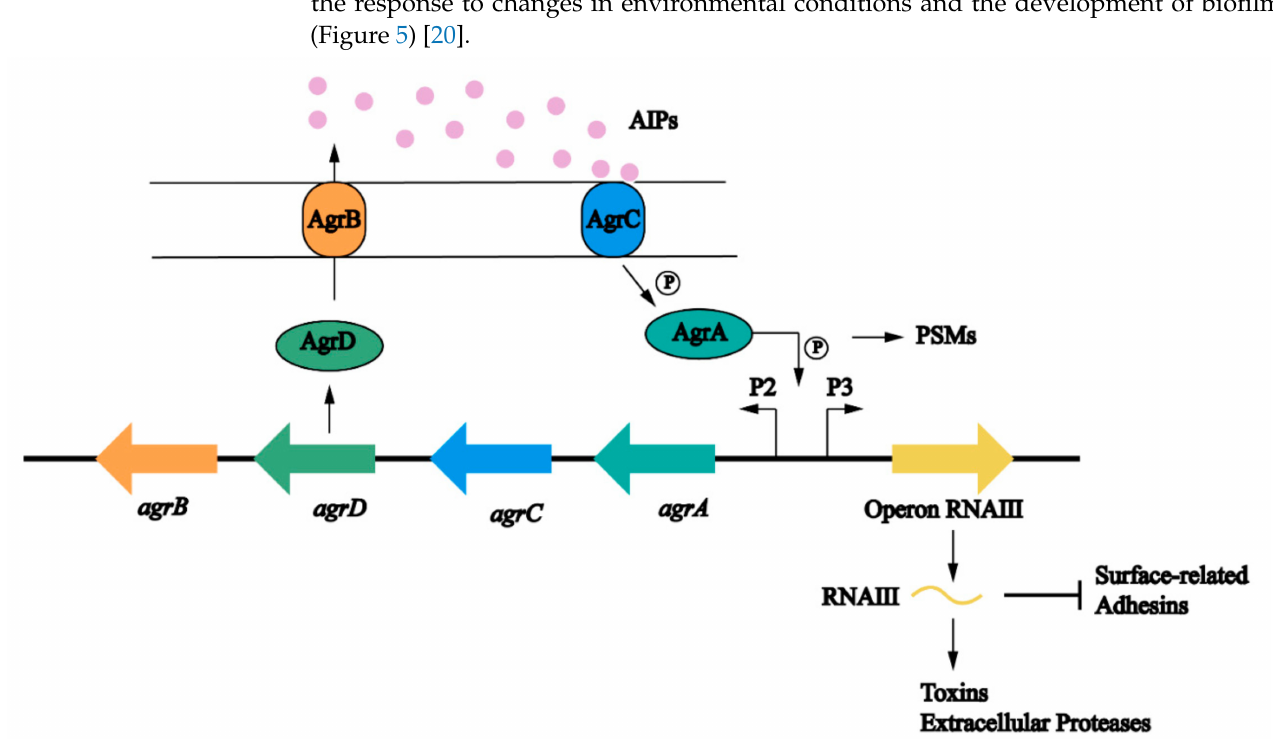
Figure 4. The role of the Agr quorum sensing system in biofilm formation in S. aureus . The Agr system is controlled by agr operon. AgrD is the precursor of self-induced peptides (AIPS), which is modified by AgrB and secreted into the extracellular matrix. AIPs are intracellular signal molecules that respond to cell density. When the bacterial density increases, AIP activates the transmembrane protein AgrC. Phosphorylated AgrC further activates AgrA and finally promotes the expression of target genes. AgrA acts on P2, which regulates the Agr protein, and P3, which can activate RNAIII expression. RNAIII is the effector molecule of agr locus. RNAIII induces the expression of virulence factors, such as protease and toxin. On the other hand, RNAIII also inhibits the expression of surface adhesion proteins